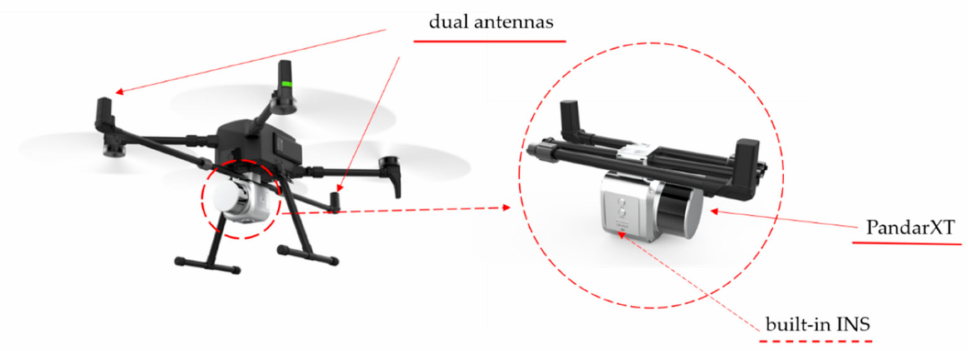
Figure 2. The CBI-200P system carried on the quad-rotor UAV platform. The INS system is